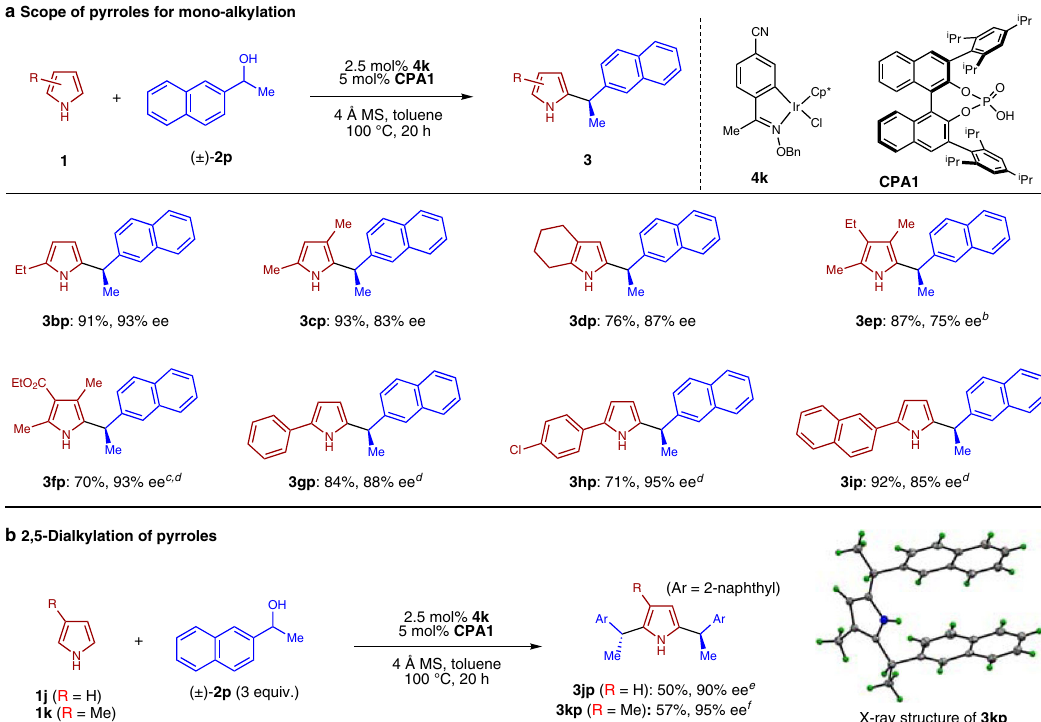
Fig. 4 Scope of pyrroles for enantioconvergent heteroarylation using alcohol 2p a . a Scope of pyrroles for enantioconvergent heteroarylation of 2p . b 2,5- Dialkylation of pyrroles. a Reaction conditions: 1a (0.20 mmol), 2a (0.40 mmol), 4 (0.005mmol), CPA1 (0.01 mmol) and 4 Å MS (20 mg) in toluene (0.5 mL) at 100 °C under N 2 for 20 h, unless otherwise noted. See supplementary information for details. b Reaction performed at 80 °C. c Reaction performed at 130 °C. d Reaction performed with 5 mol% 4k and 10 mol% CPA1 . e Reaction performed with 4 mol% 4k and 8 mol% CPA . f Reaction performed at 90